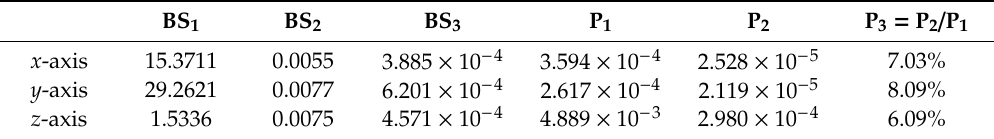
Table 3. Bias stabilities of the experimental data in 1st experiment.